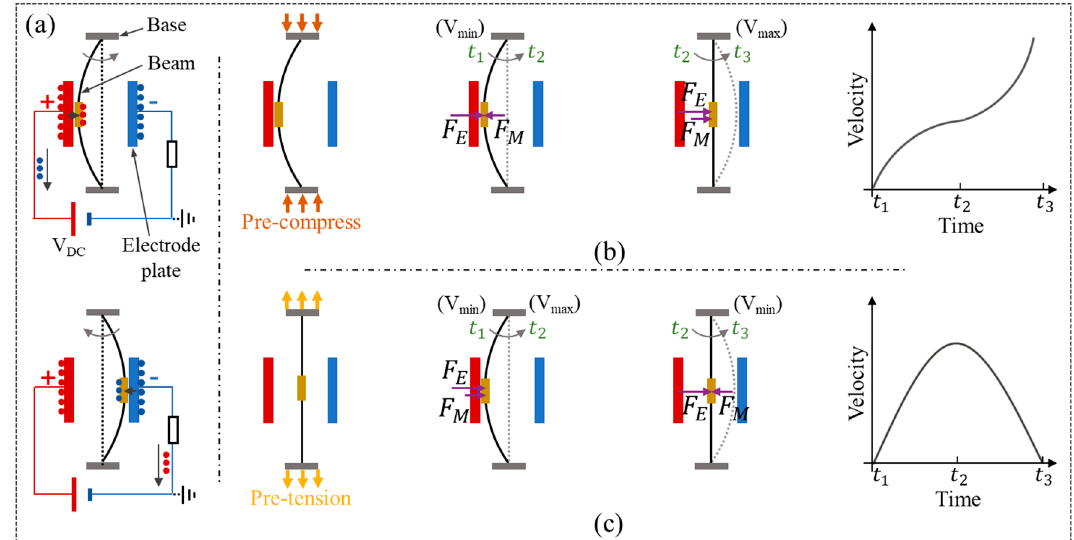
Figure 1. Structure, working principle, and force analysis of the electrostatic self-excited resonator with pre-compression and pre-tension constraints: ( a ) The charge flows in the circuit when the beam makes contact with the positive and negative electrode. ( b ) The force analysis of the microbeam under pre-compression constraint. ( c ) The force analysis of the microbeam under pre-tension constrain.